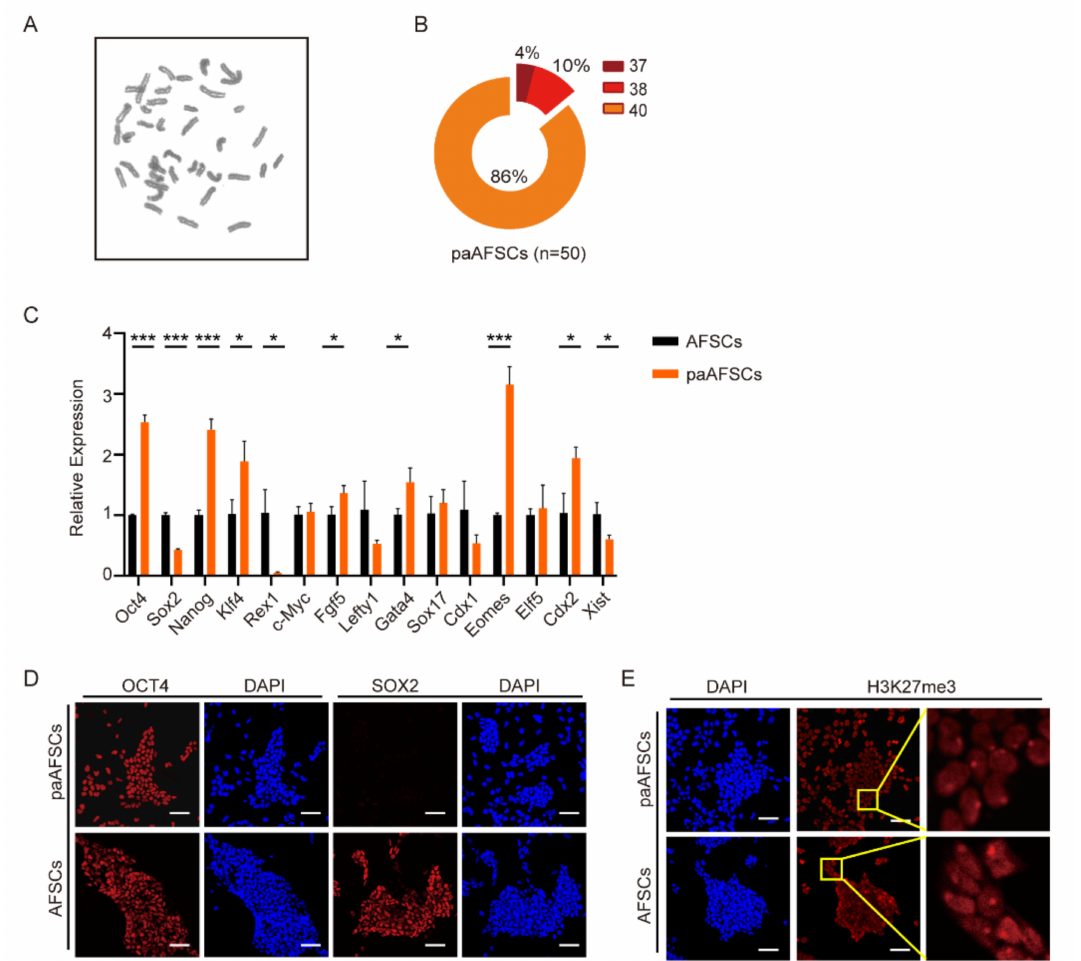
Figure 2. Characteristics of paAFSCs: ( A ) Karyotype of paAFSCs. ( B ) Distribution of paAFSCs with different chromosome numbers; n = 50. The cells with a normal karyotype accounted for 86% in paAFSCs. ( C ) RT-qPCR of key pluripotent genes, germ-layer-related genes, and X-chromosome-inactivation-related gene in AFSCs and paAFSCs. Error bars indicate three independent biological replicates (mean ± SD); * p < 0.05, *** p < 0.0001. ( D ) Immunostaining for pluripotent markers OCT4 and SOX2 in AFSCs and paAFSCs; scale bars: 50 µ m. ( E ) Immunostaining detection of H3K27me3 foci in AFSCs and paAFSCs; scale bars: 50 µ